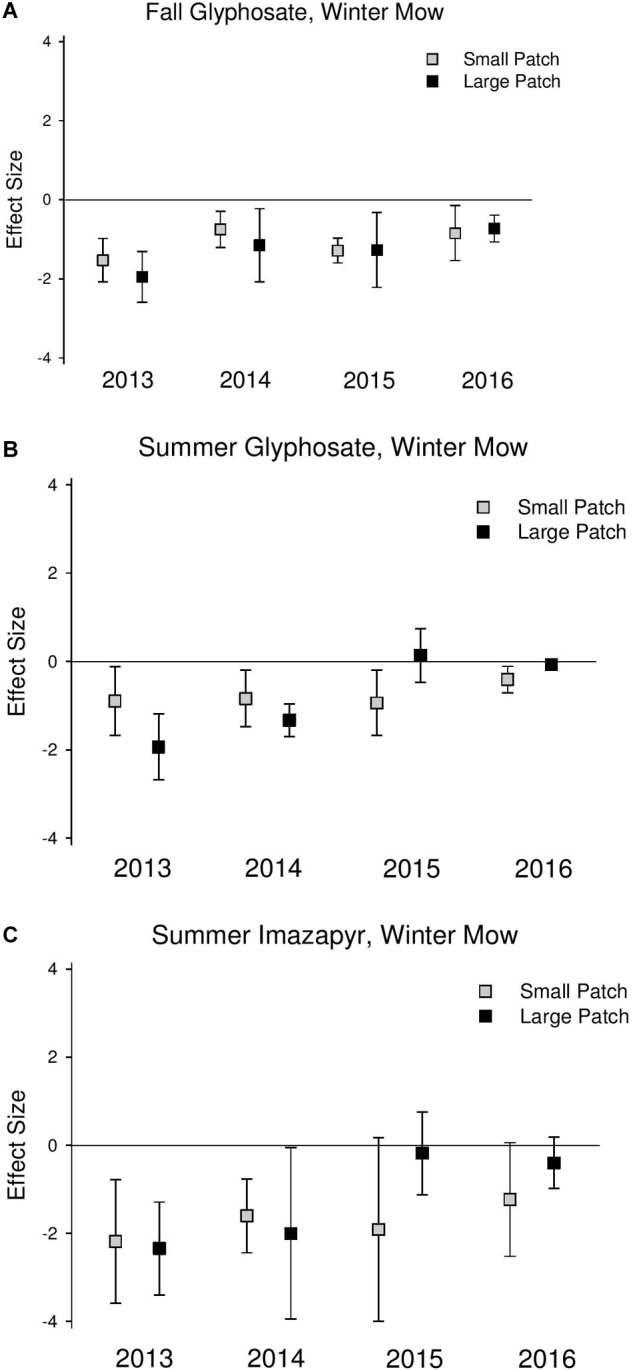
Effect size graphs for Phragmites cover for three herbicide treatments [(A) fall glyphosate, winter mow, (B) summer glyphosate, winter mow, and (C) summer imazapyr, winter mow]. Points are effect sizes at each scale, in each year, bounded by the upper and lower limits of the 95% confidence interval.